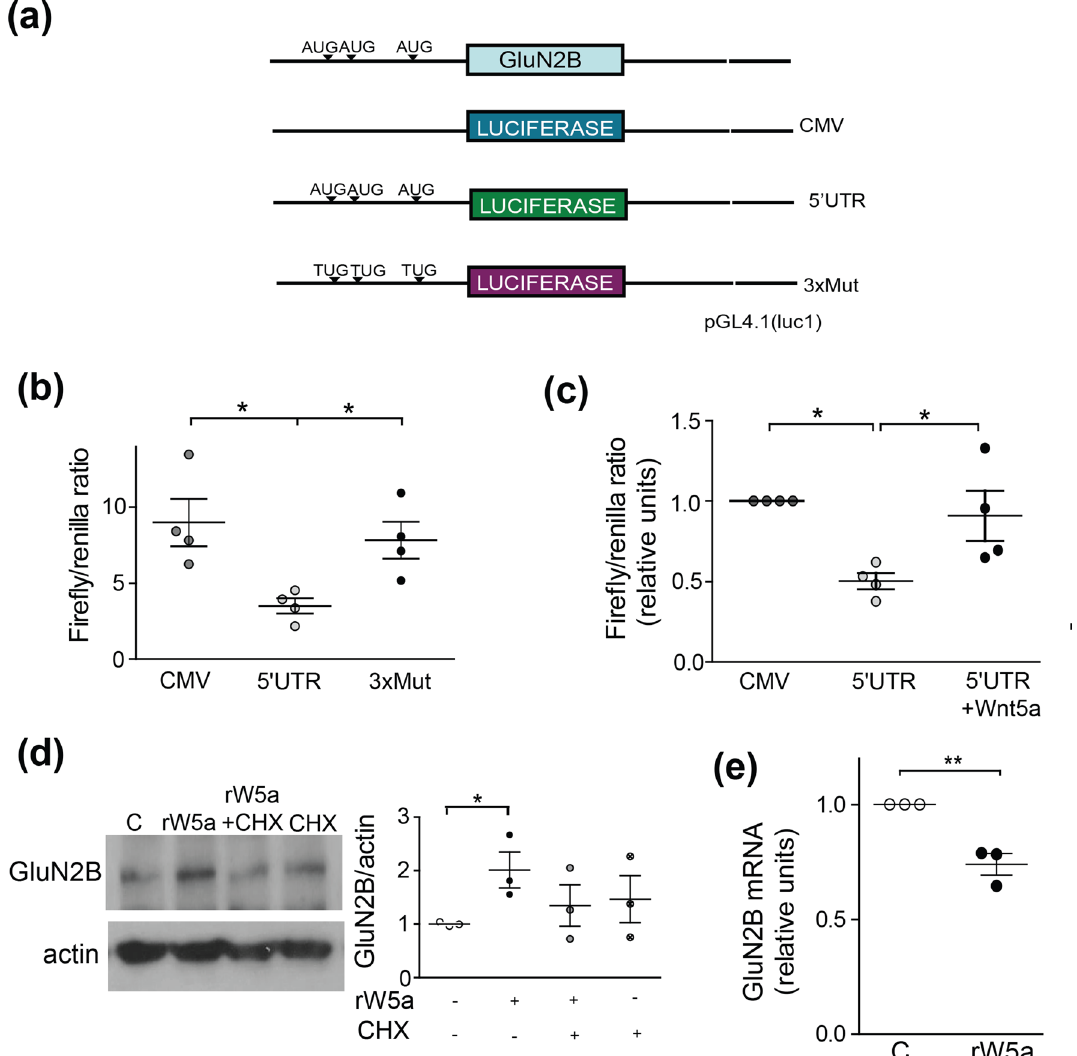
Figure 4. 5 ′ UTR-GluN2B translational de-repression by Wnt5a ligand ( a ) Scheme depicting the 5 ′ UTR of the GluN2B subunit (179 bp and 3 upstream AUGs), and the luciferase constructs designed for the reporter assay. CMV, contains luciferase gene under CMV promoter; 5 ′ UTR, contains 5 ′ UTR from GluN2B cloned between the CMV promoter and luciferase gene; 3xMut, contains the 5 ′ UTR with the three uAUGs mutated to uTUGs. ( b ) Luciferase assay in HT22 cells transfected with the 3 reporter vectors. Lines show the mean ± SEM. N = 4 independent experiments (* p = 0.00.41; p = 0.0157) ( c ) Luciferase assay in hippocampal primary neurons transfected with the vectors and treated with Wnt5a, expressed as relative units. Lines represent mean ± SEM. N = 4 (* p = 0.0011; p = 0.0288; p = 0.0245) ( d ) Representative blot showing hippocampal neurons treated with 300 ng/mL recombinant Wnt5a (rW5a), rW5a+CHX or CHX. The plot shows the GluN2B expression relative to actin levels. Lines show the mean ±SEM.N=3 independent experiments. Dunnett’s Multiple comparison test (* p = 0.0315). ( e ) qRT-PCR from total RNA isolated from hippocampal neurons after 1 h of not treated or treatment with rW5a. GluN2B mRNA levels were normalized to GAPDH mRNA and expressed relative to control condition. Lines represent mean ± SEM. N = 3 independent experiments (** p = 0.0051). Full-length blots are presented in Supplementary Fig.